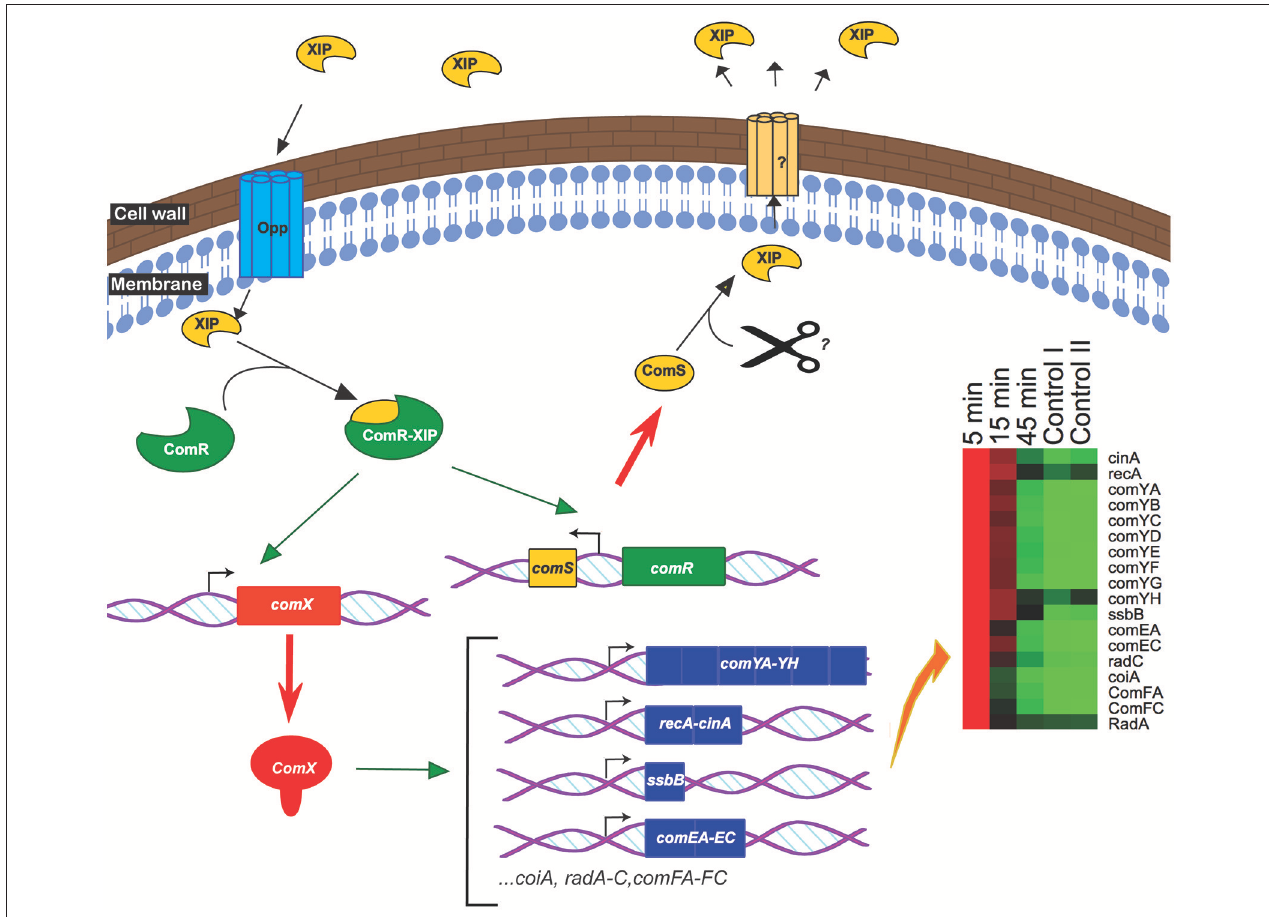
FIGURE 5 | Simplified model of competence induction in S. suis . Extracellular SigX-inducing-peptide (XIP) enters the bacteria via the Opp transporter system. Intracellularly, the transcriptional regulator ComR binds to XIP and the ComR-XIP complex promotes the expression of comS , encoding the full-length form of the XIP pheromone, and of comX (green arrow). ComX activates the expression (green arrow) of the late-competence genes involved in the transformasome having a CIN-box in their promoter (heatmap). ComS is processed and secreted by an unknown mechanism inducing a positive feedback loop.